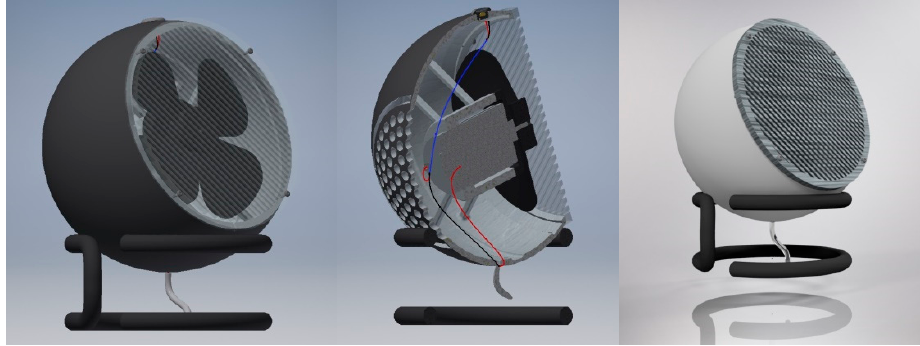
Figure 15. Final assembly and rendering.